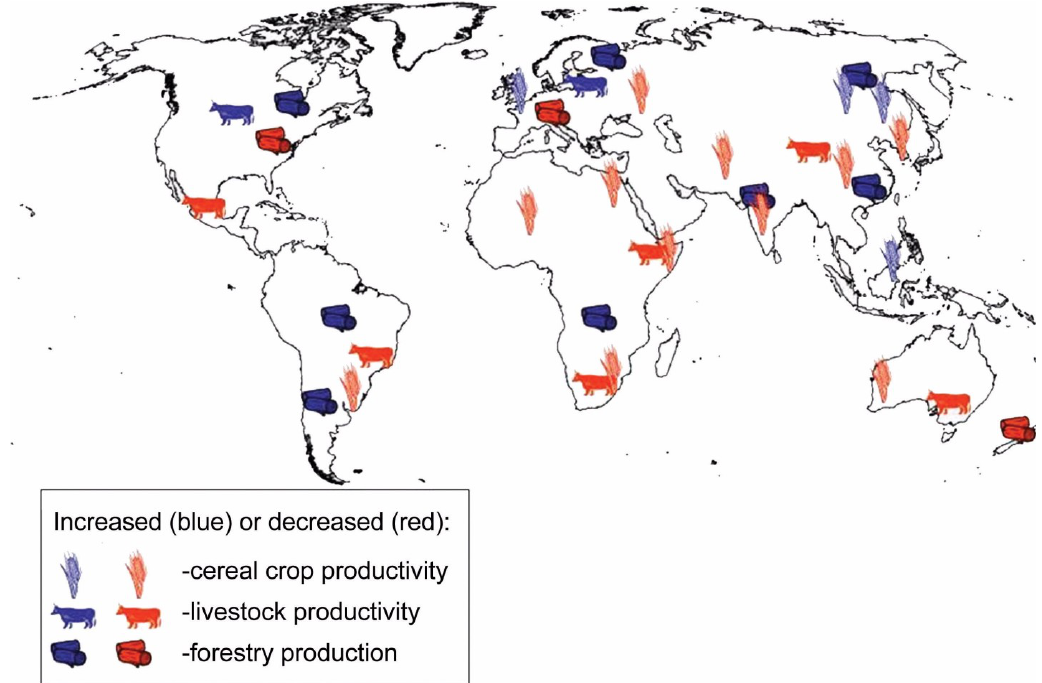
Figure 7. Expected major impacts of climate change on crop and livestock yields and forestry production by 2050, shown by region. Figure 5.4 from